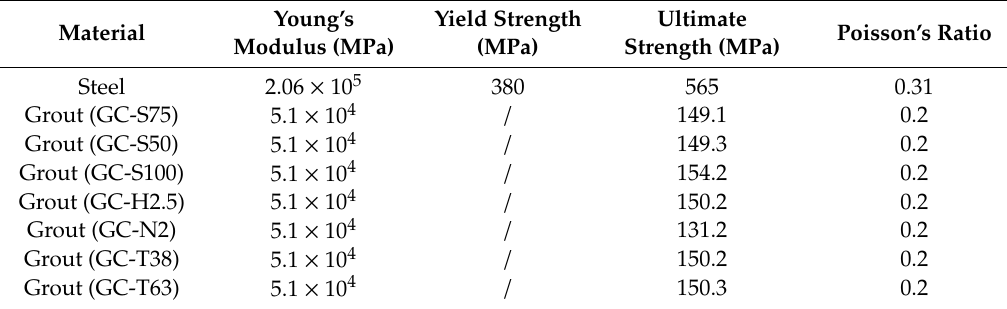
Table 4. Material